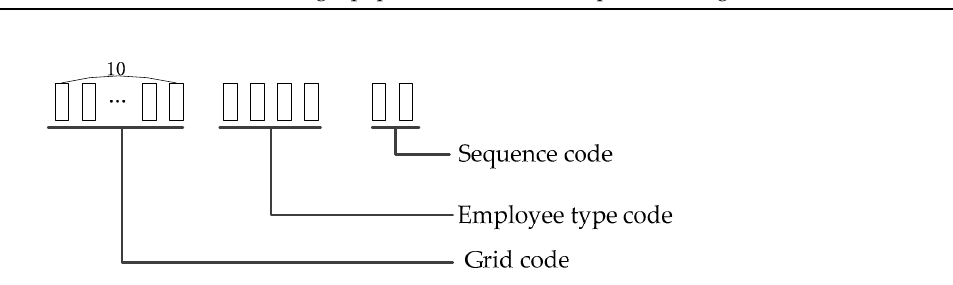
Figure 4. Code structure of grid elements in the train operation department.